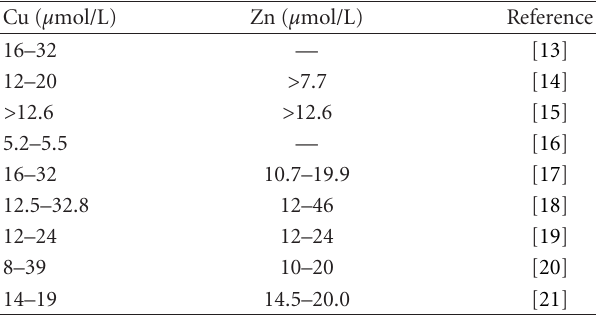
Table 1: Di ff erent reference values for copper and zinc in blood serum in the